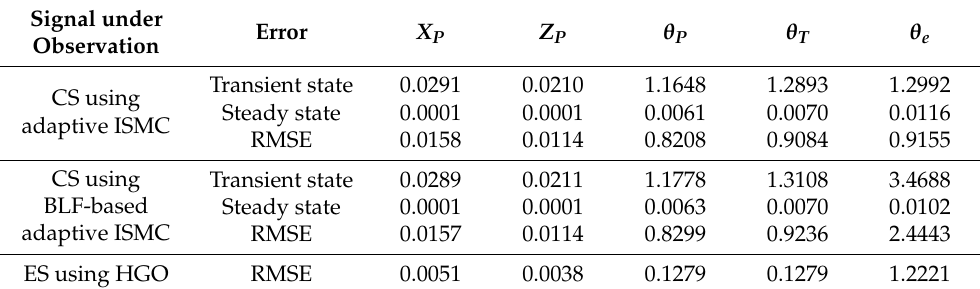
Figure 3. The response of barge − type 5DOF TORA − based OFWT without applying control laws, ( a ) 𝑋 (cid:3017) , ( b ) 𝑍 (cid:3017) , ( c ) 𝜃 (cid:3017) , ( d ) 𝜃 (cid:3021) , and ( e ) 𝜃 (cid:3032) , where brown results do not apply the proof ‐ mass actuator in the OFWT model and green results do apply the proof-mass actuator in the OFWT model. Table 2. Error analysis of the controlled states (CS) and estimated states